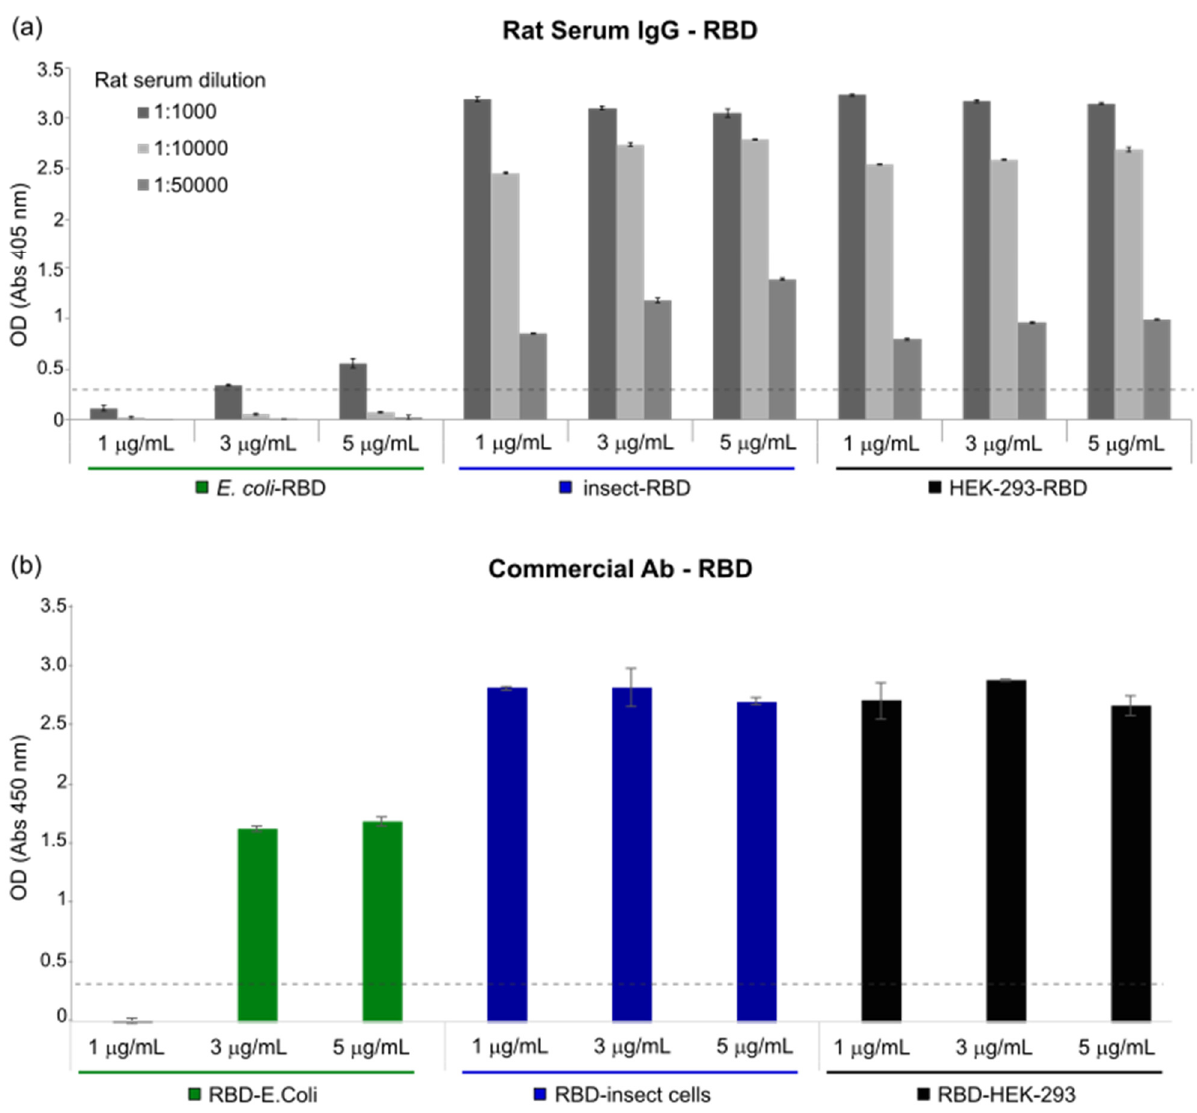
Figure 3. ELISA assays. ( a ) Serum from immunized rat with COVID- e Vax was used to compare different concentrations (1, 3 and 5 µ g/mL) of the RBD expressed in E. coli (green), insect (blue) and HEK-293 cells (black). The y -axis represents the optical density (OD) measured at 405 nm, while the x -axis accounts for RBD concentrations and serum dilution factors (1:1000, 1:10000 and 1:50000). Bars indicate standard deviations. Dashed line = cut-off value. ( b ) Commercial antibody against the S1 subunit of SARS-CoV-2 Spike was used to compare different concentrations (1, 3 and 5 μ g/mL) of RBD produced in E. coli (green), insect (blue) and HEK-293 cells (black). Optical density (OD) was measured at 450 nm and bars indicate standard deviations. Dashed line = cut-off value.